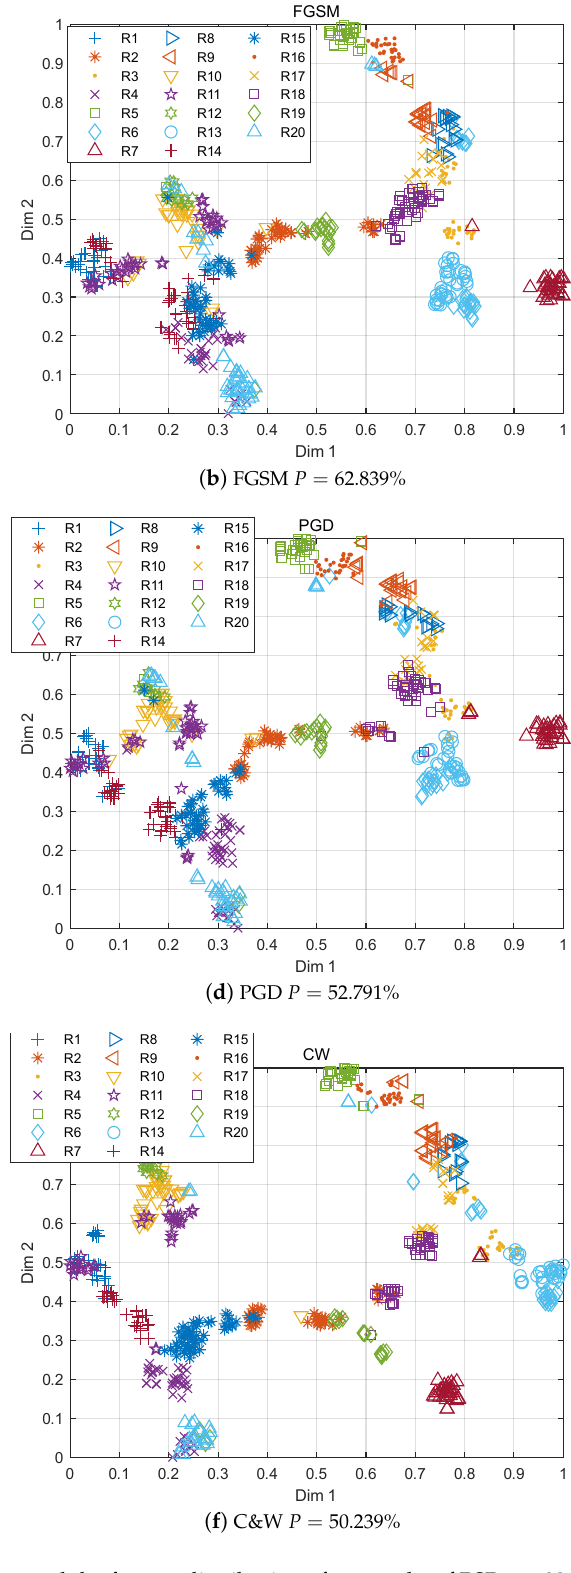
Figure 10. Identification performance and the feature distribution after attacks of PSR = − 32 dB for Dataset 1. The figures of the first column represent the confusion matrices, and the second column is for low-dimensional feature